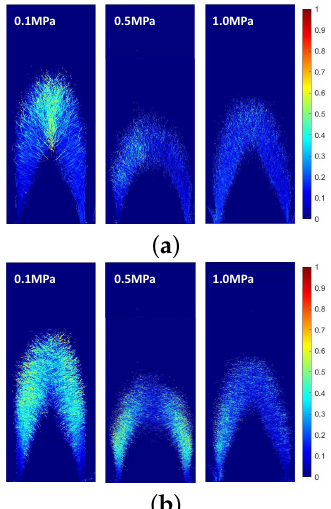
Figure 10. Pressure effect on the evaluation of (cid:104) n 2 D The fluctuating components (cid:104) m 2 D According to Equations (16) and (17), (cid:104) m 2 D tuating in the third direction. (cid:104) m 2 D larger than other parts of the flame, while (cid:104) m 2 D whole flame region. Moreover, a more uniform value of (cid:104) m 2 D high pressure. This also verifies that the wrinkled flame front is closer to being isotropic at high pressure.